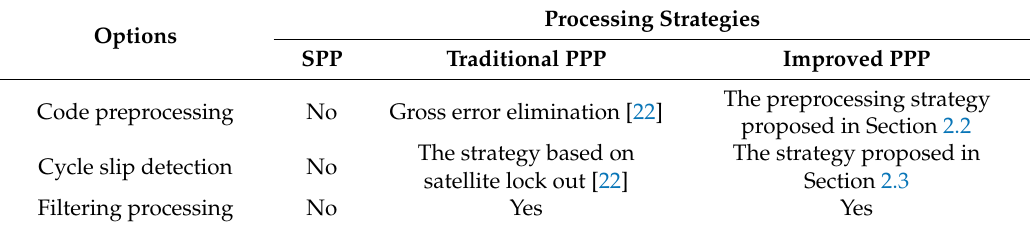
Table 3. The di ff erences of detailed settings of positioning projects, where improved PPP employs ionosphere-constrained single-frequency PPP model described in Section 2. The other settings of the three projects employed the setting proposed in Table